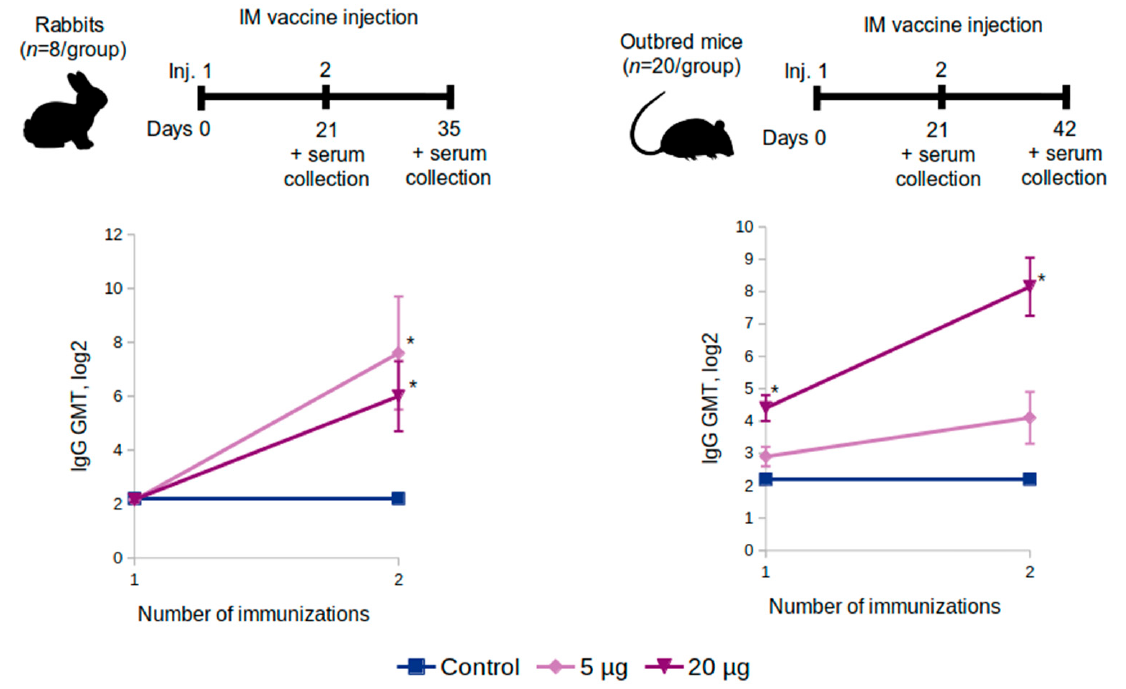
Figure 5. The growth of the GMT level of antibodies specific to the SARS-CoV-2 RBD protein in the serum of the intramuscularly immunized rabbits ( left ) and outbred mice ( right ) with “Betuvax-CoV-2” at 5 and 20 µ g/animal; * p < 0.05.